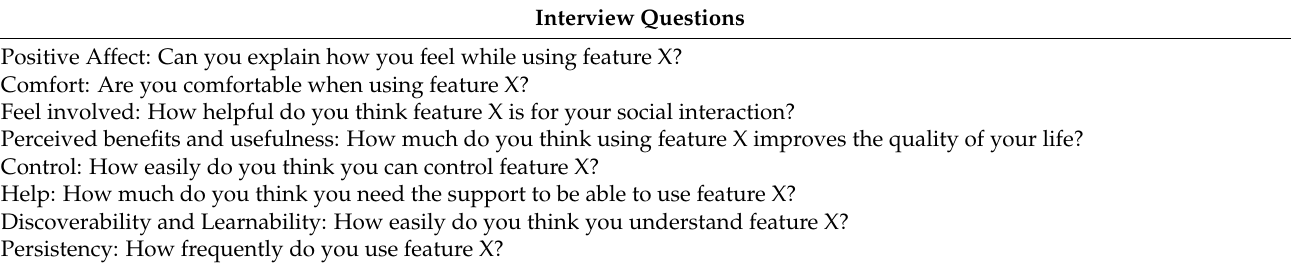
Table 1. Interview Questions used for qualitative